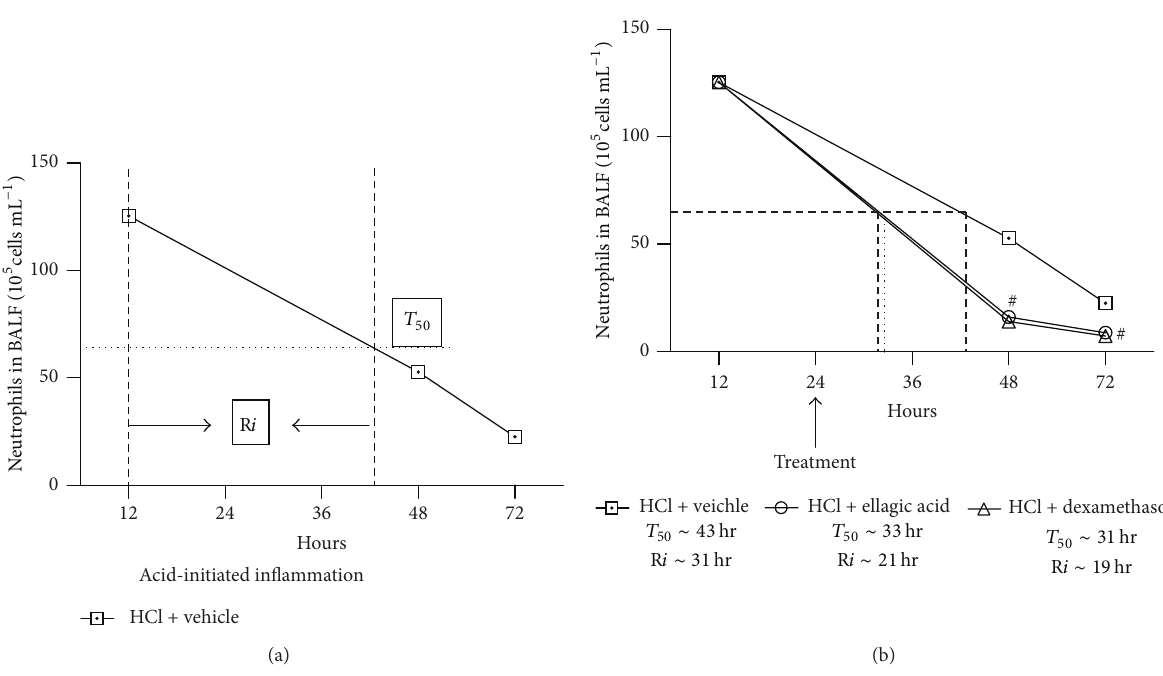
Figure 7: Ellagic acid accelerates the resolution of inflammation of acid-initiated acute lung injury. 𝑇 50 correspond to the time point to reduce ∼ 50% of neutrophils. The resolution interval (R i ) is defined as the time required for cell numbers to decrease to 50% of the maximum at peak inflammation (the interval between peak of inflammation (at 12h) and 𝑇 50 ). These indices were calculated when ellagic acid, dexamethasone, or vehicle were administrated in the resolution phase at 12h after the peak of inflammation (24 h). Results represent the mean ± SEM of two or more independent experiments with three mice per group per experiment. ∗ 𝑃 < 0.05 compared with control group; # 𝑃 < 0.05 compared with HCl + vehicle